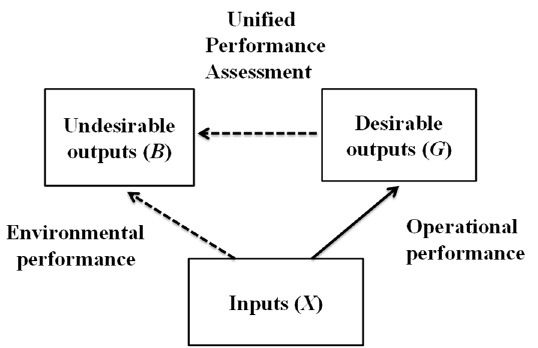
Figure 2. Relationship among three production factors. The arrows indicate direct and indirect relationships among three production factors. The dot arrows indicate indirect causality.